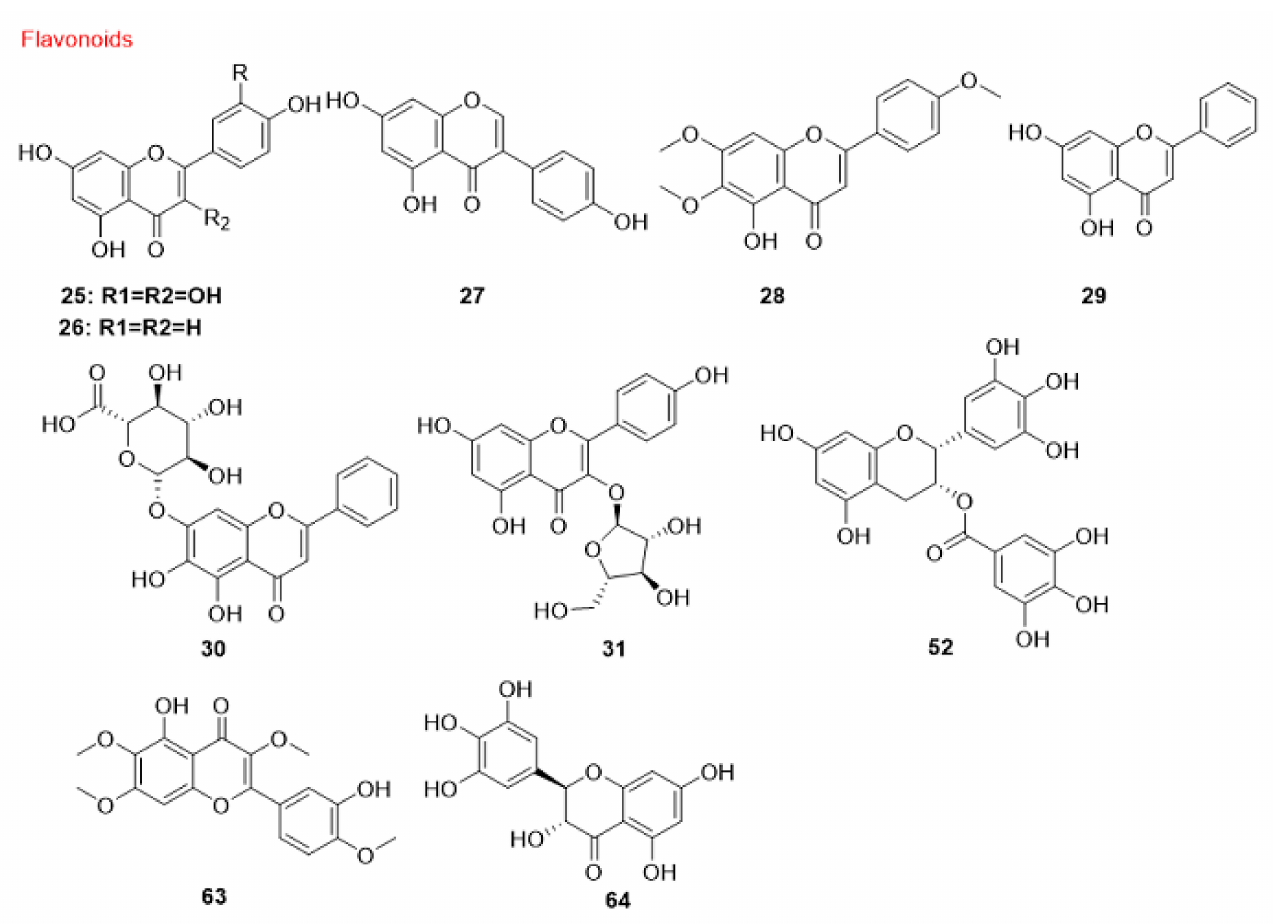
Figure 10. Chemical structures of flavonoids. Quercetin (25), apigenin (26), genistein (27), salvigenin (28), baicalin (30), juglanin (31), epigallocatechin gallate (52), casticin (63), ampelopsin (64). The images were prepared using ChemDraw Professional